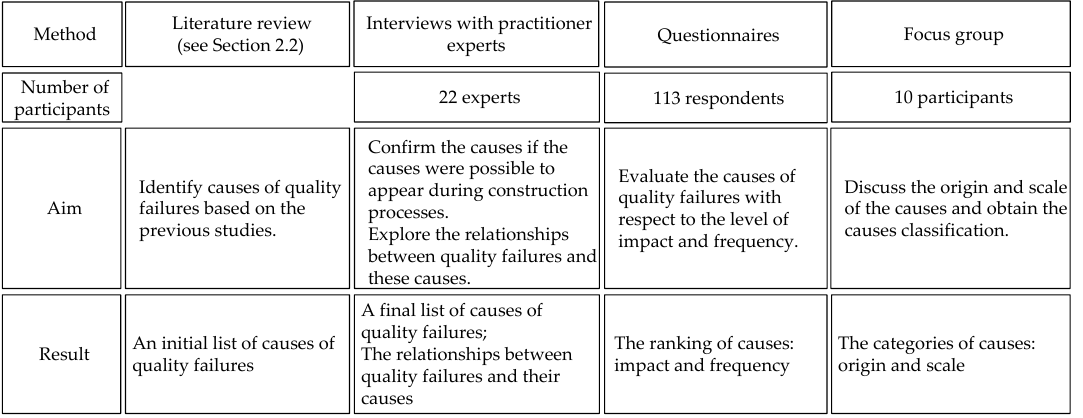
Figure 2. The research method, objective, and results.